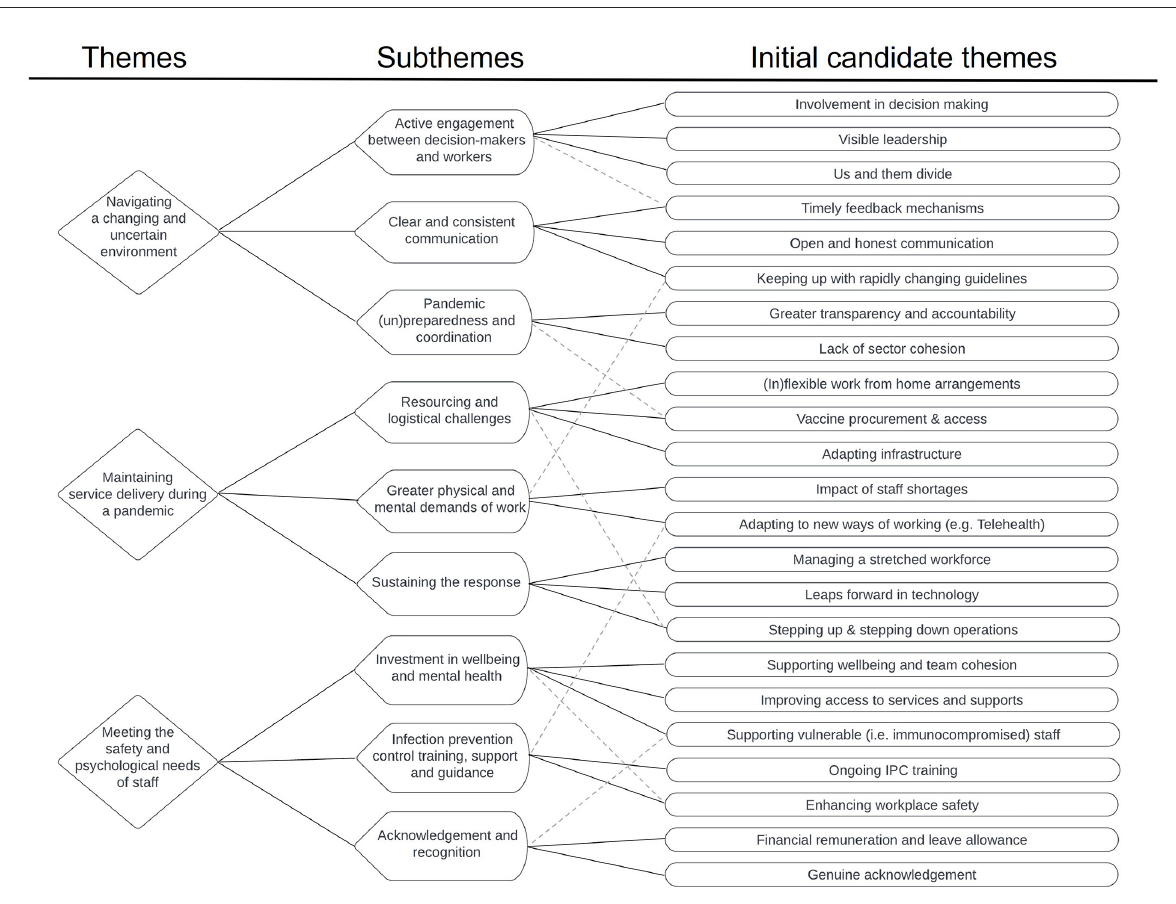
FIGURE1 Thematic tree of findings showing the evolutionary process of theme conceptualization. *Dotted lines indicate examples where an initial candidate theme was related to multiple